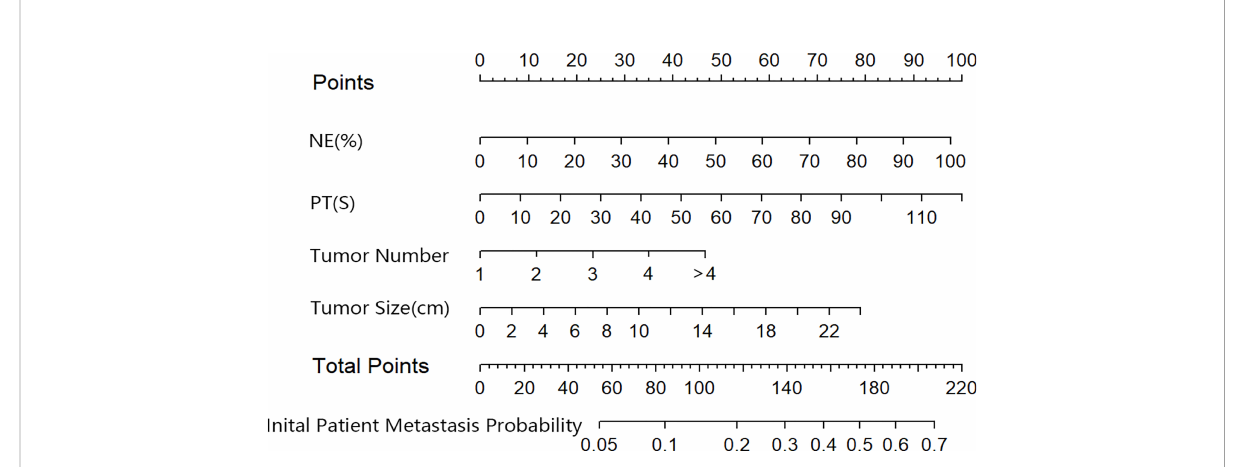
FIGURE 3 The nomogram predicting initial patient EHM probability. NE, neutrophil; PT, prothrombin time.